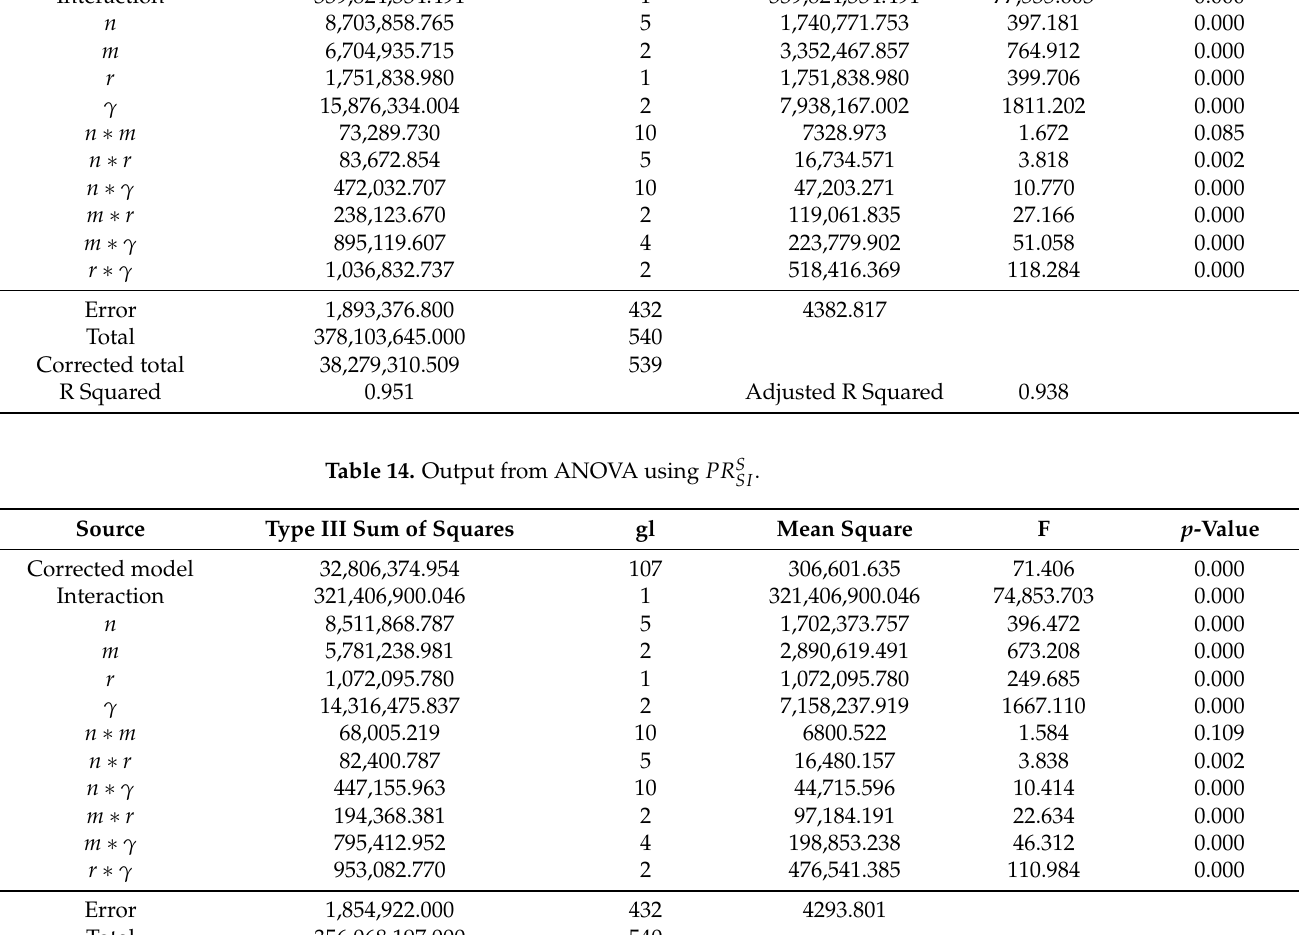
Table 13. Output from ANOVA using Model 1.